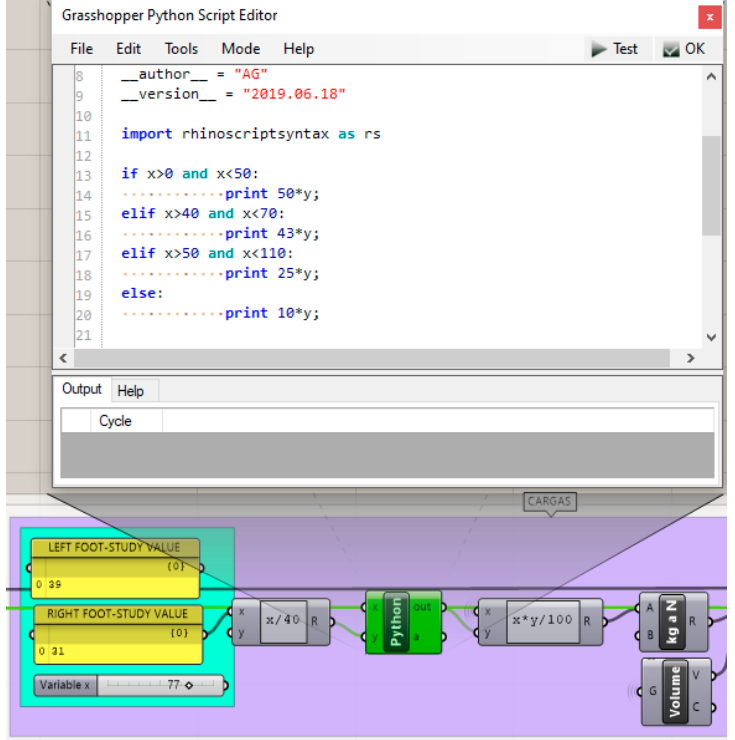
Figure 20. Programming structure for the calculation of the load distribution in the right hindfoot.